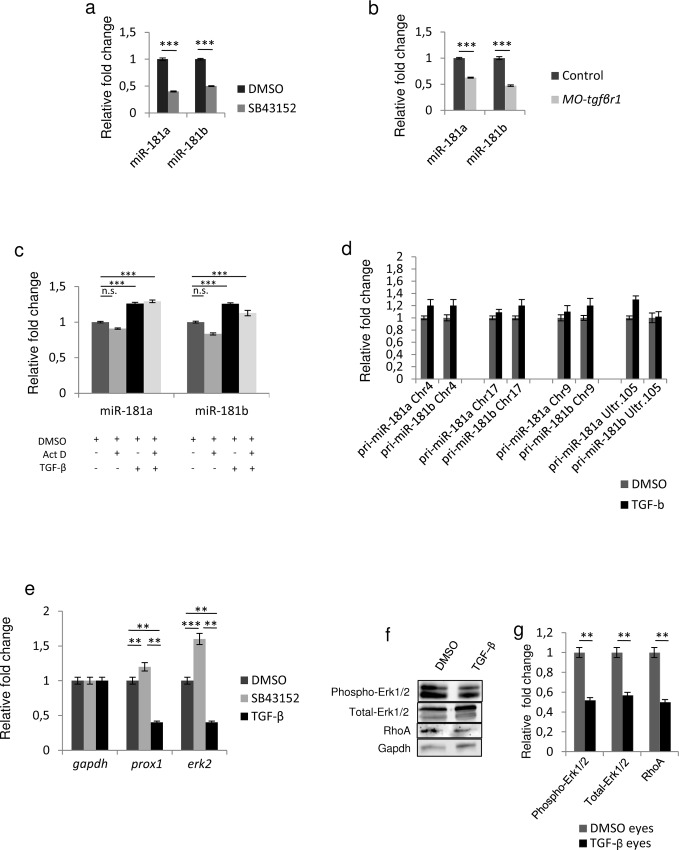
TGF-β signaling regulates mature miR-181a/b expression levels.
(a-b) TGF-β pathway inhibition leads to a decrease in the expression levels of mature miR-181a and miR-181b. (a) Administration of SB432542, a TGF-β receptor inhibitor, induced a decrease of miR-181a and miR-181b mature forms in St32 eyes with respect to DMSO treatment, as detected by Taqman assays. The miR-181a and miR-181b reduction was comparable with that observed in the morpholino-mediated inhibition of the TGF-β pathway (MO-tgfβr1) at St32 (b). Data are means +SEM. ***, P <0.001 (t-tests). (c-d) TGF-β treatment (10ng/ml) leads to increased levels of miR-181a and miR-181b mature forms in medaka fish St32 eyes in a transcription-independent manner. (c) Administration of TGF-β (10ng/ml) for 24 h (from St30 to St32) led to the increase of mature miR-181a and miR-181b in St32 eyes, as assessed by Taqman assays. Co-treatment with TFG-β and actinomycin D for 24 h (from St30 to St32) did not alter the TGF-β effect on mature miR-181a/b levels. These results indicate that the TGF-β effect on miR-181a/b expression is not transcription-dependent. Data are means +SEM. ***, P <0.001 (two-way ANOVA). (d) qRT-PCR on RNA extracted from DMSO- and TGF-β-treated St32 medaka fish eyes for all the pri-miR-181a and pri-miR-181b transcripts derived from the different genomic loci present in the medaka fish genome. After 24 h (from St30 to St32) of TGF-β treatment (10ng/ml), there were no significant changes in pri-miR-181a/b levels with respect to DMSO treatment. (e) qRT-PCR on RNA extracted from DMSO-, SB432542- and TGF-β-treated St32 medaka fish eyes. In the SB432542-treated eyes the decrease of miR-181a/b levels led to increased prox1 and erk2 transcript levels, whereas in TGF-β-treated eyes the miR-181a/b increase was accompanied by reduced transcript levels of both prox1 and erk2. Data are means +SEM. **P <0.01; ***, P <0.001 (Two-way ANOVA). (f-g) Representative Western blotting (f) and corresponding quantification (g), showing a decrease of total-, phospho-Erk2 proteins and of its downstream target RhoA in TGF-β-treated St32 medaka fish eyes. Data are means +SEM. **P <0.01 (t-tests).